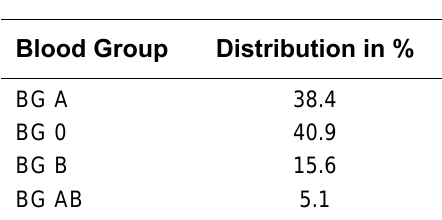
Blood Group Distribution in